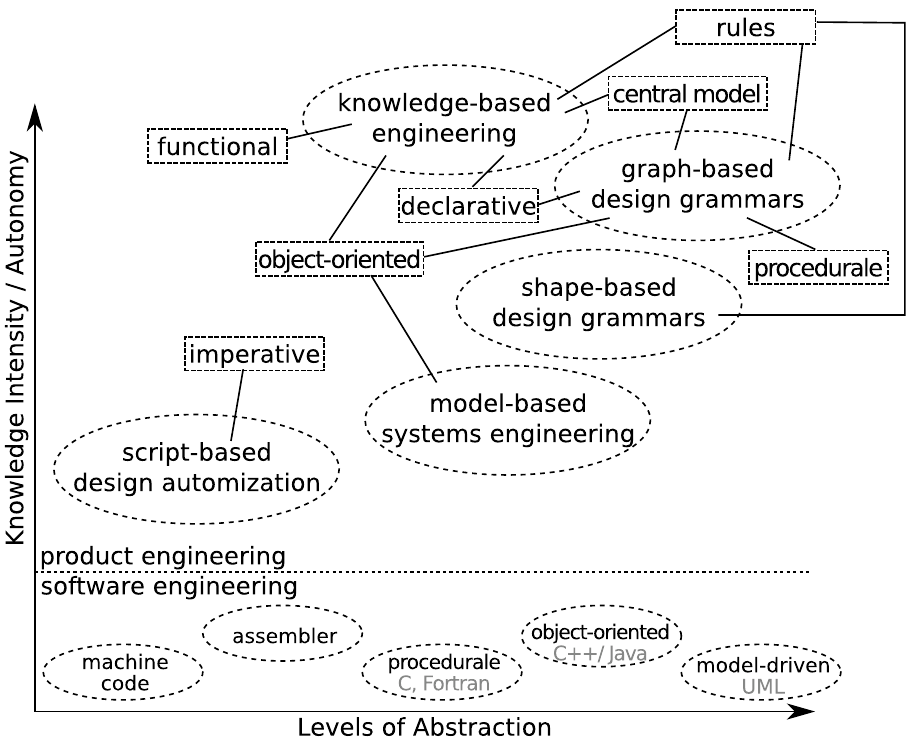
Fig. 1 The level of abstraction versus knowledge-intensity for different methods of engi- neering automation (ovals). The boxes assign the key properties of the approaches. Analogously, the different lev- els of abstraction in software engineering are shown below. Taken from